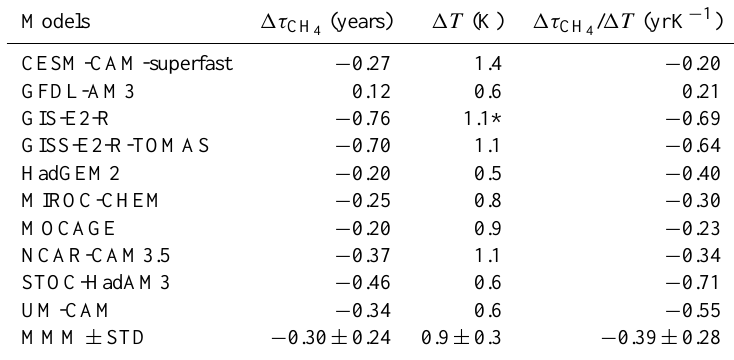
Table 6. Change in tropospheric methane lifetime ( τ CH tion with 1850 climate (Em2000Cl1850). Change in tropospheric temperature ( 1T ) and lifetime change per unit change in temperature ( 1τ CH / 1T ) are also shown for 10 4